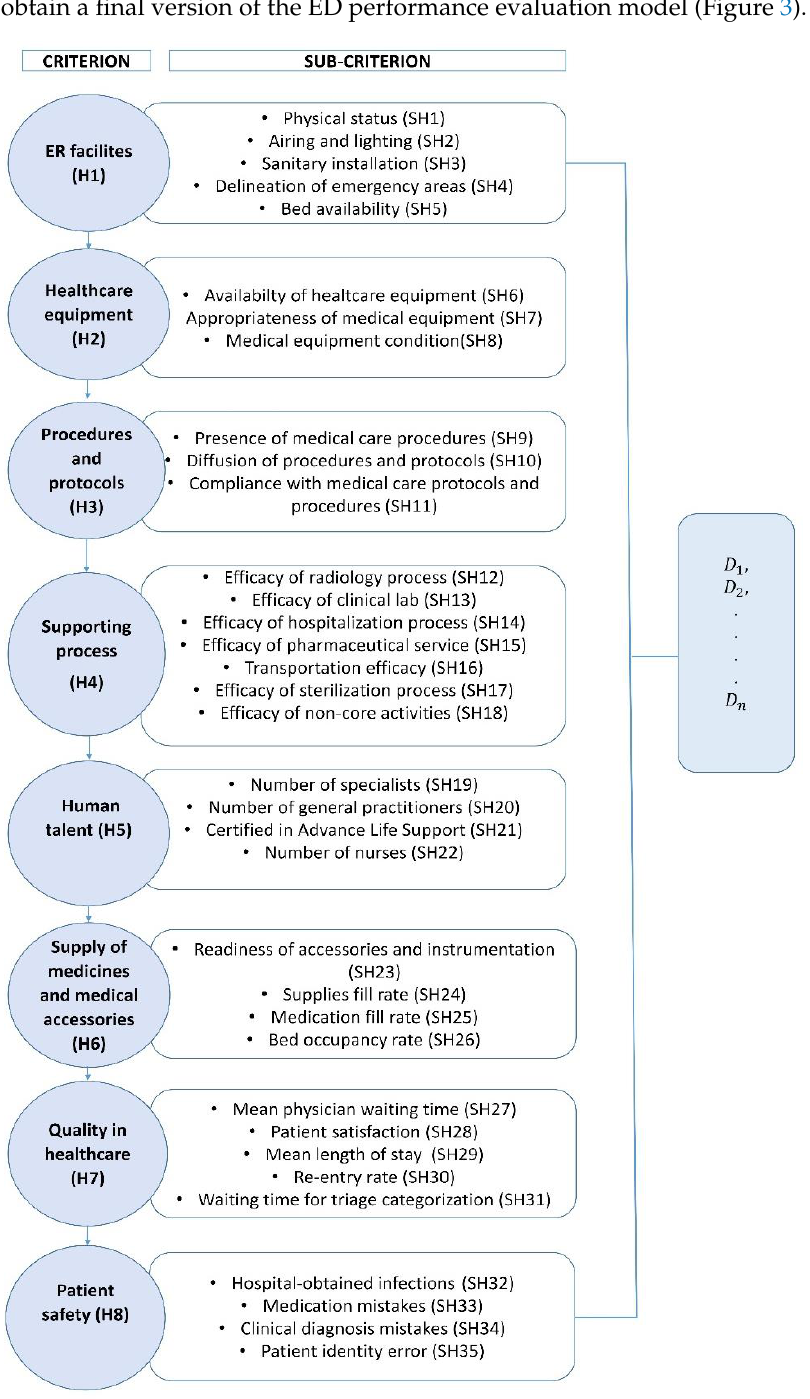
Figure 3. Decision network for performance evaluation of emergency care centers during the COVID-19 waves.